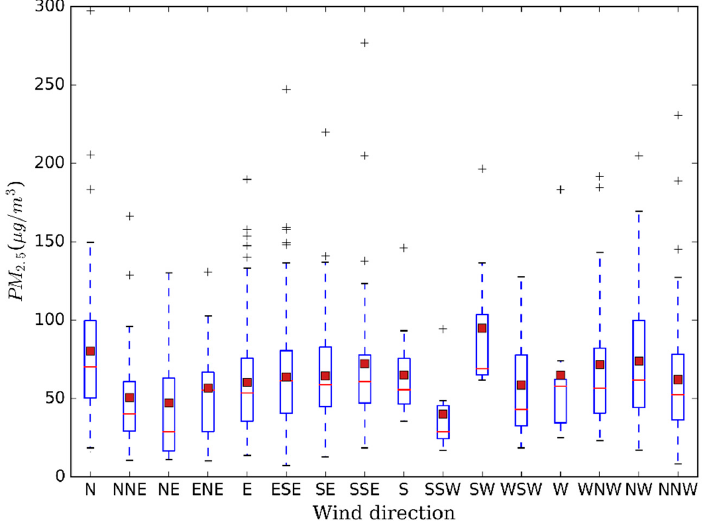
Figure 10. Box-Whiskers plot of PM 2.5 mass concentration related with wind direction. Bottom and top of the blue box represent 25th and 75th percentile, whereas bottom and top of the vertical dotted line mean minimum and maximum value. The red solid lines represent median value and the firebrick square represent mean value. Outliers are depicted by the “+”.